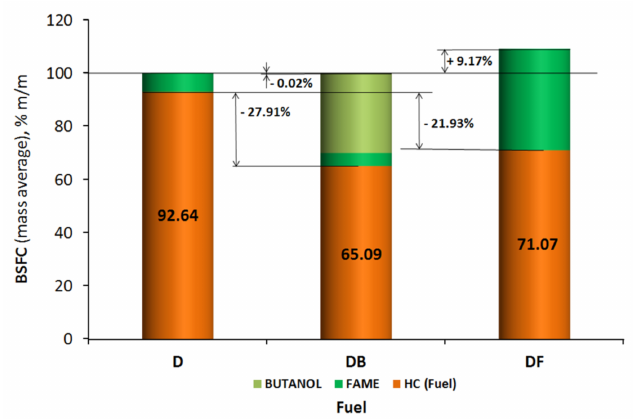
Figure 12. Percentage by relative mass of components in fuels consumed in the ESC